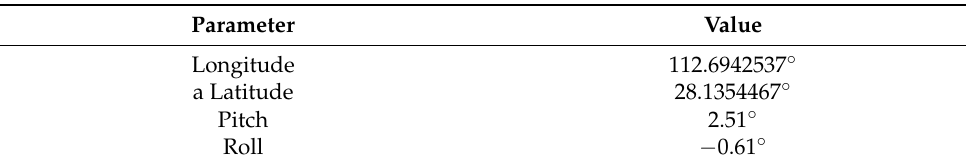
Table 3. The orientation of the image in Figure 35.